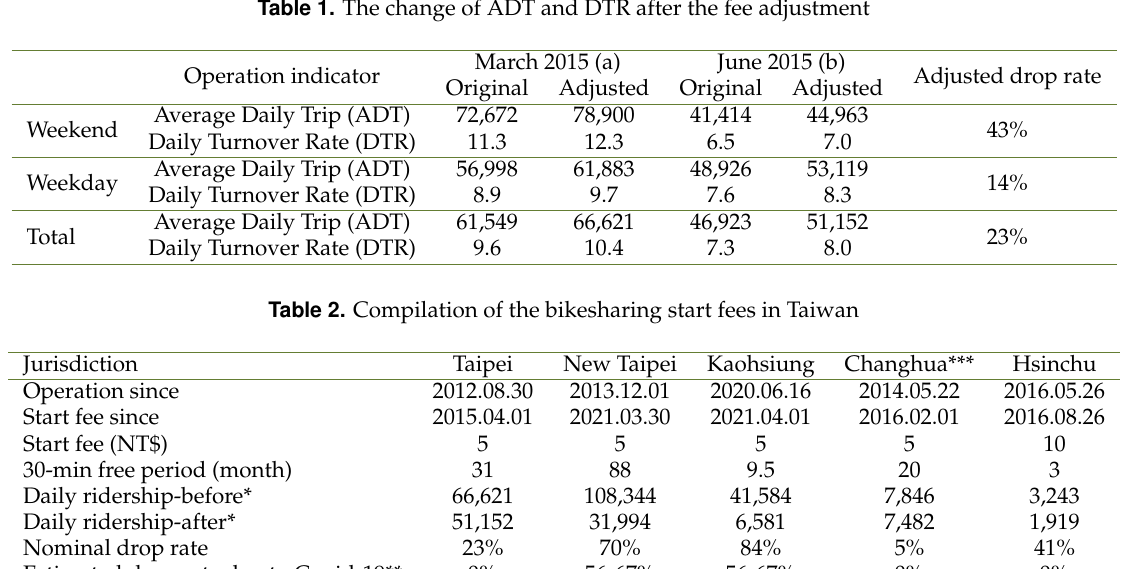
Table 1. The change of ADT and DTR after the fee adjustment